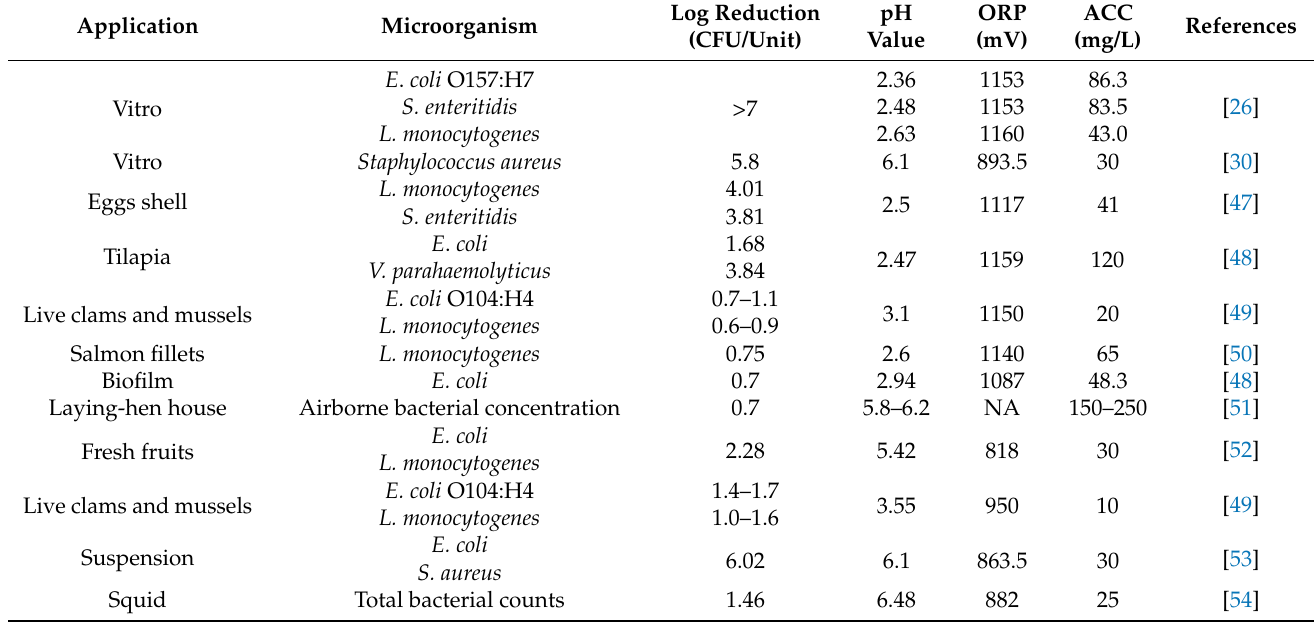
Table 2. Summary of EW’s antimicrobial